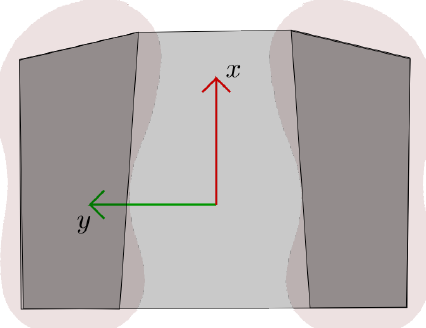
Figure 5. Approximation of the support area of the foot. The darker grey zones delimit the support areas for single support cases. The lighter grey zone changes according to the positions of the